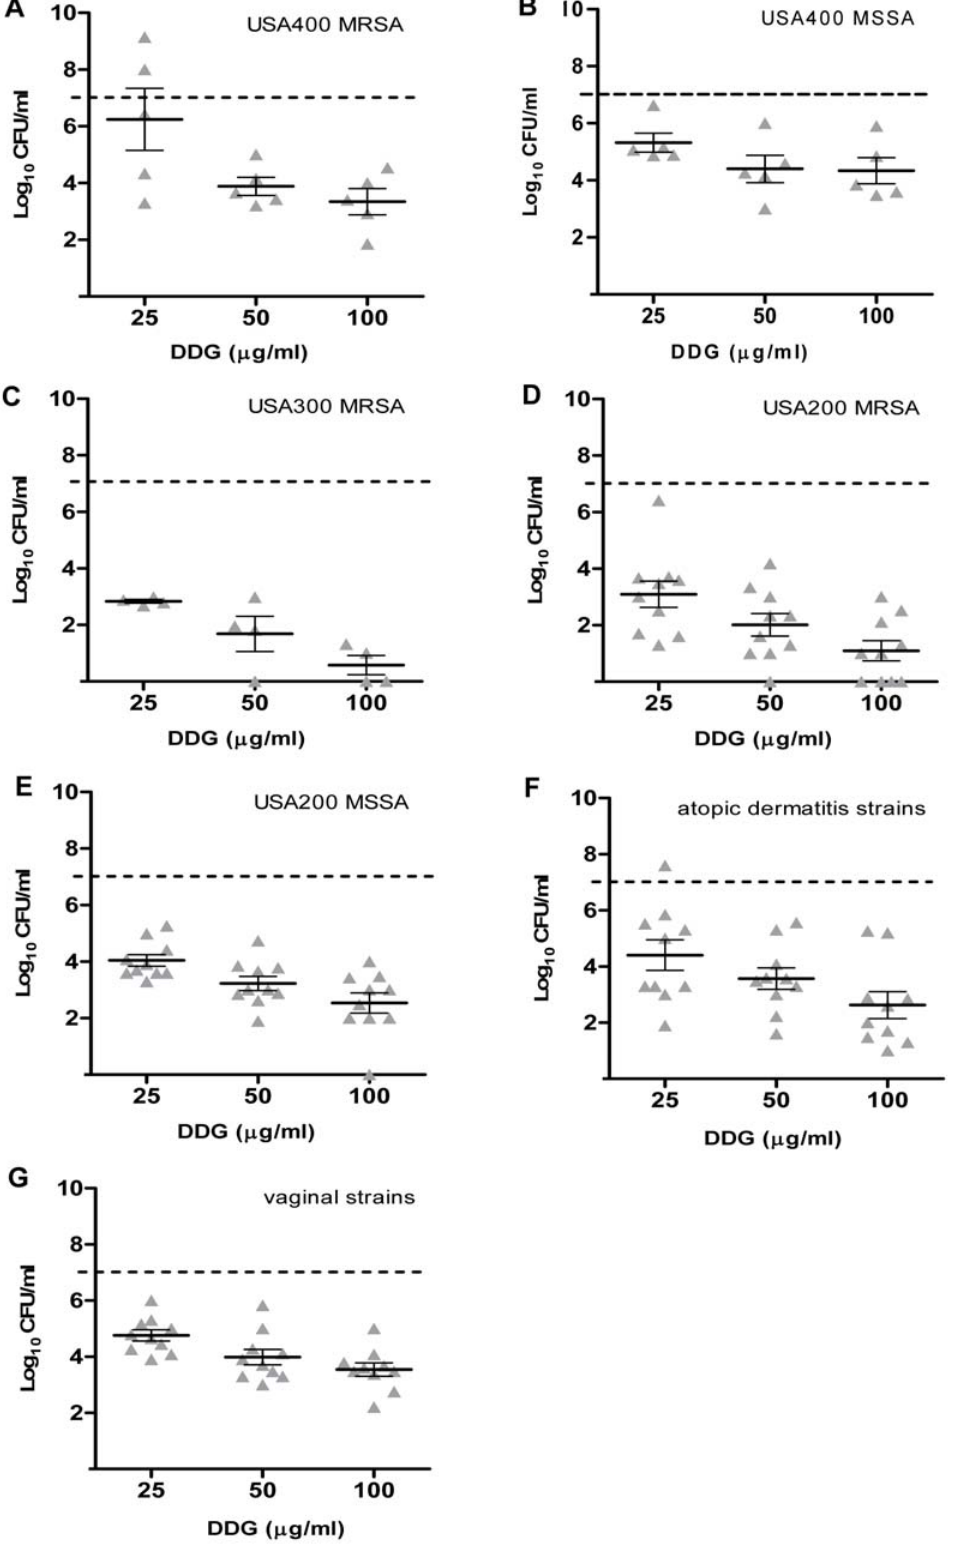
Figure 3. Dodecylglycerol (DDG) inhibition of Staphylococcusaureus . DDG concentrations 25, 50, and 100 m g/ml were tested versus S. aureus isolates from different PFGE types, USA400 MRSA (A), USA400 MSSA (B), USA300 MRSA (C), USA200 MRSA (D), USA200 MSSA (E), atopic dermatitis strains (F), vaginal strains from healthy women (G), for 18 h at 37 u C with shaking. The dashed line indicates the starting inocula. Each triangle ( m ) indicates one isolate. The bars represent the mean 6 SEM of bacterial density in the group.